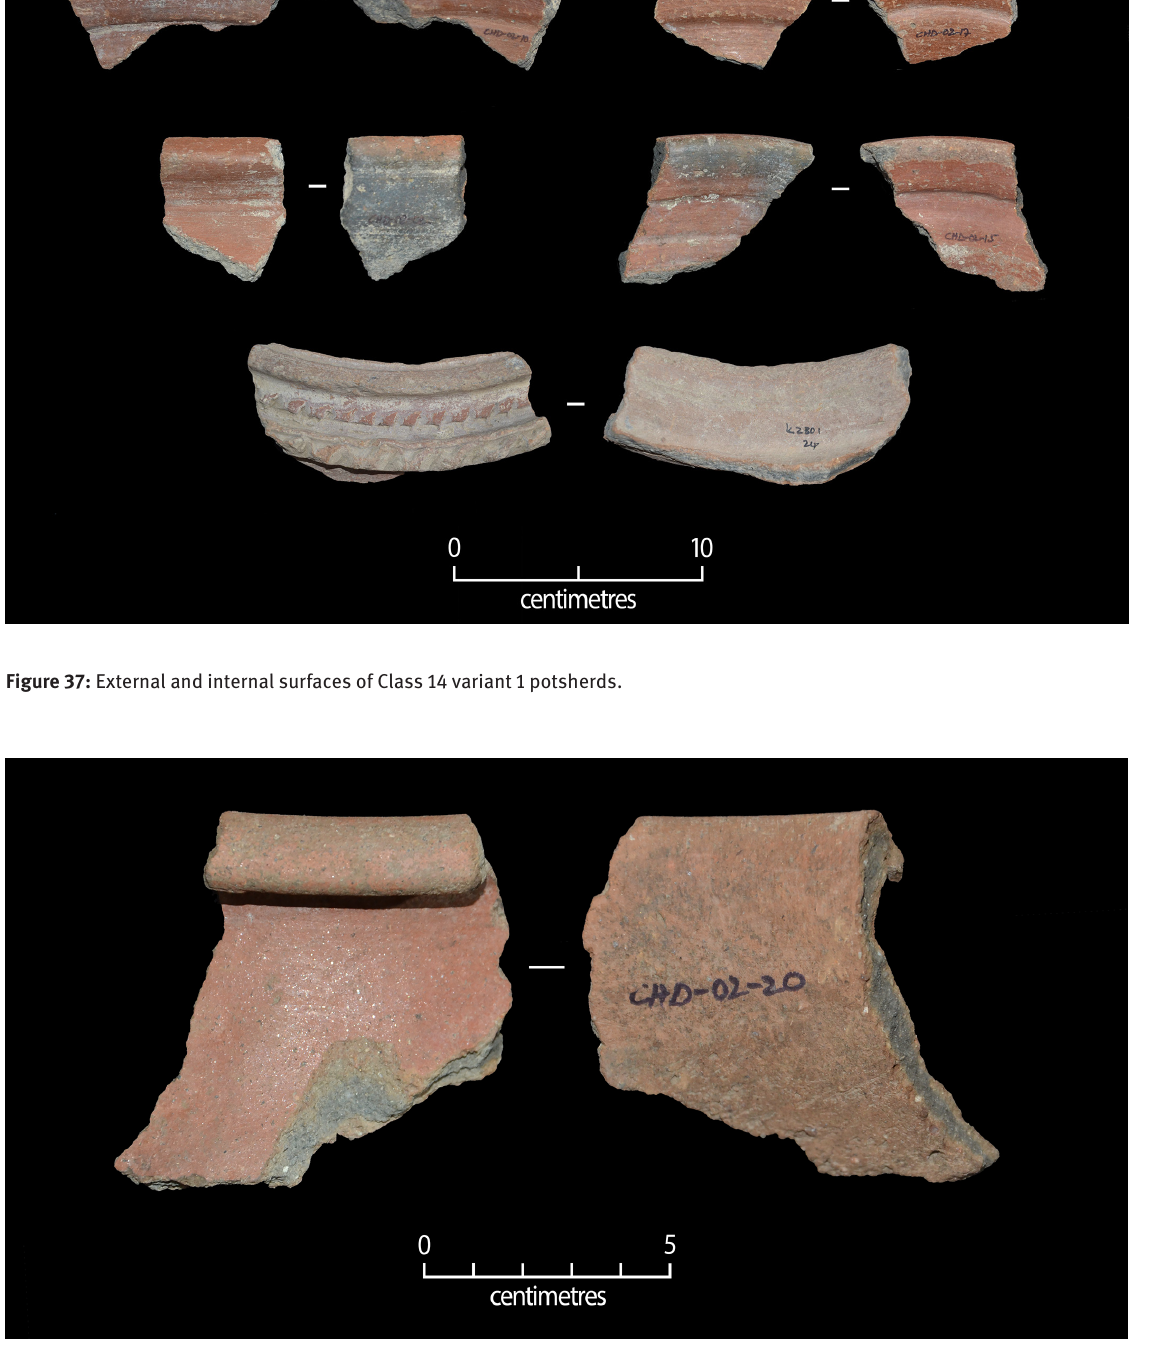
Figure 38: External and internal surfaces of a Class 14 variant 2